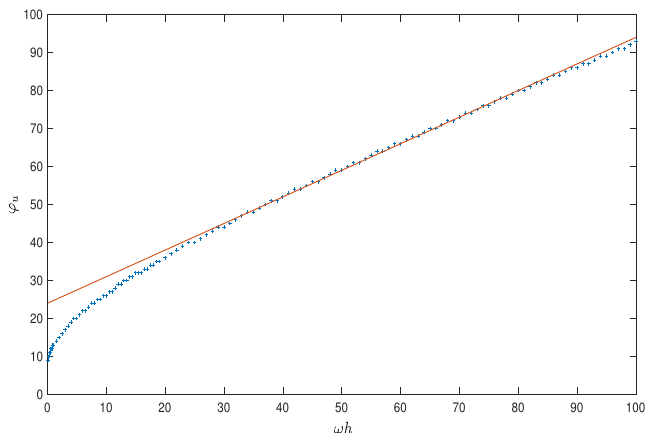
Figure 2. Plot of the function ϕ u defined in (104) versus ω h (blue plus line), for the double precision IEEE, together with its linear approximation (105) (red solid